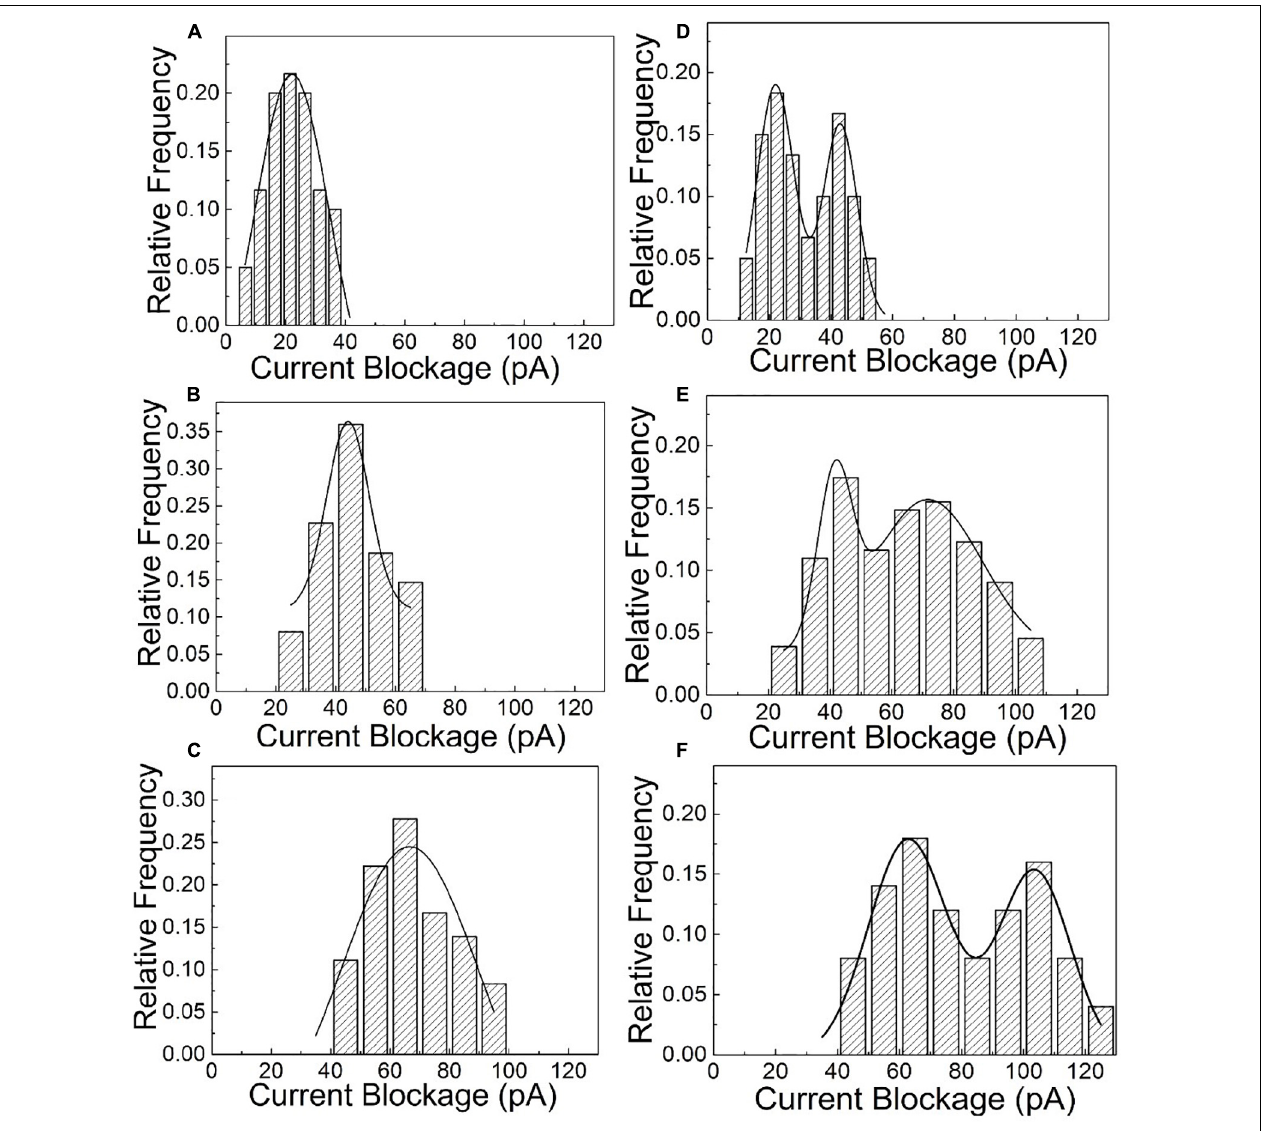
FIGURE 4 | The statistical amplitude histograms of the blocked translocation events for wild-type and mutant targets as the function of biased voltages. (A–C) Are statistical graphs at 250, 500, and 700 mV for wild-type targets, respectively. (D–F) Are statistical graphs at 250, 500, and 700 mV for SNP targets,